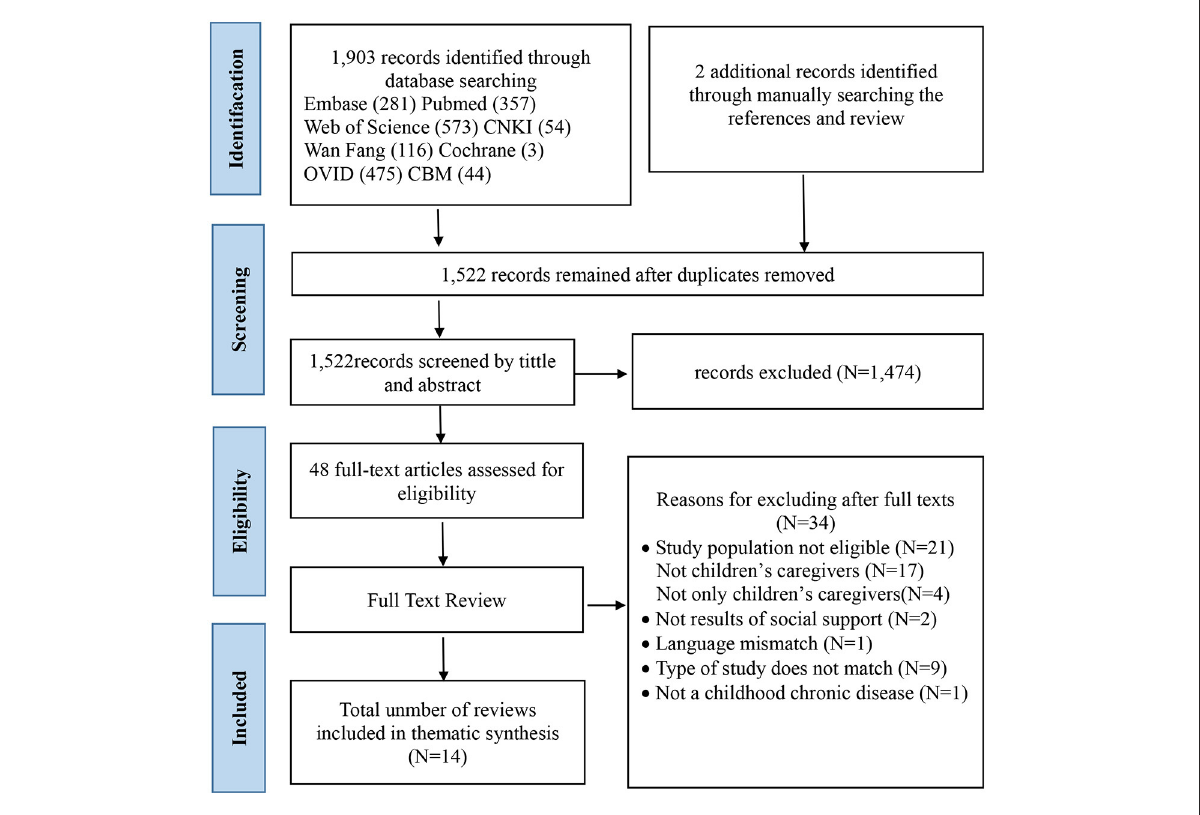
FIGURE1 PRISMA flow diagram of included